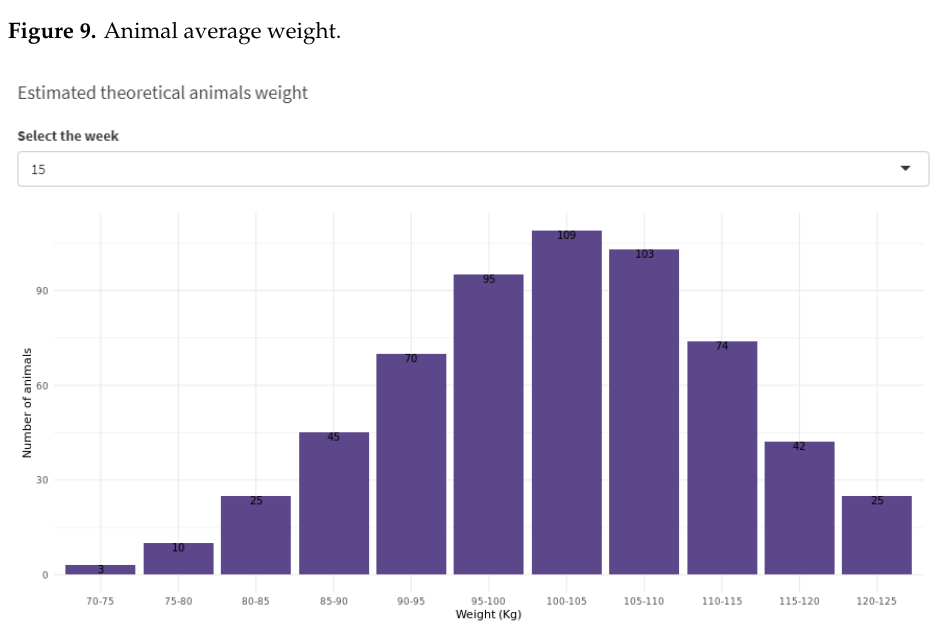
Figure 10. Animal weight distribution in a specific